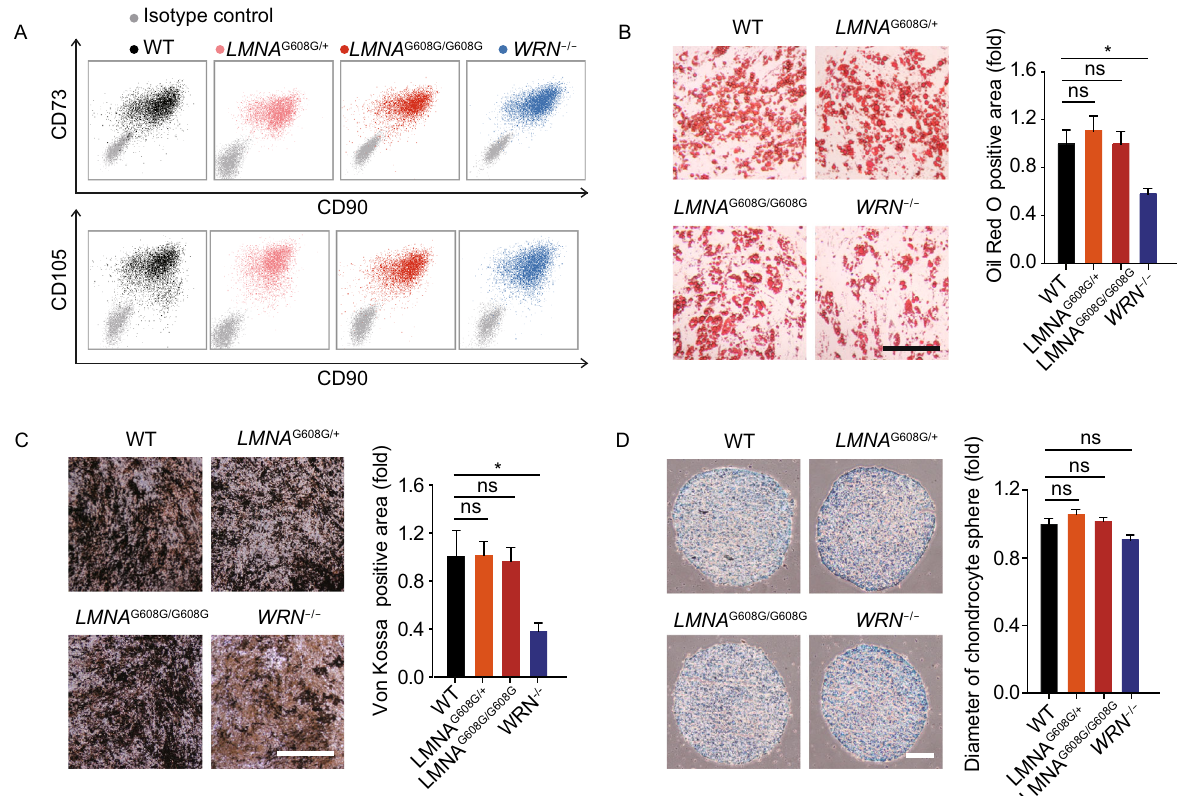
Figure 3. Acquisition and characterization of HGPS-MSCs and WS-MSCs. (A) FACS analysis of MSC-speci fi c markers (CD73, CD90, CD105) in WT, heterozygous ( LMNA G608G/+ ), homozygous ( LMNA G608G/G608G ) and WRN − / − MSCs. (B) Left: characterization of adipogenesis potential of MSCs by Oil Red O staining. Right: Oil Red O positive areas were calculated by Image J. Data were presented as mean ± SEM, n = 3. * P < 0.05; ns, not signi fi cant. Scale bar, 100 μ m. (C) Left: characterization of osteogenesis potential of MSCs by Von Kossa staining. Right: Von Kossa positive areas were calculated by Image J. Data were presented as mean ± SEM, n = 3. * P < 0.05; ns, not signi fi cant. Scale bar, 100 μ m. (D) Left: characterization of chondrogenesis potential of MSCs by Toluidine Blue O staining. Right: the diameters of chondrocyte spheres were measured. Data were presented as mean ± SEM, n = 11. ns, not signi fi cant. Scale bar, 100 μ m.